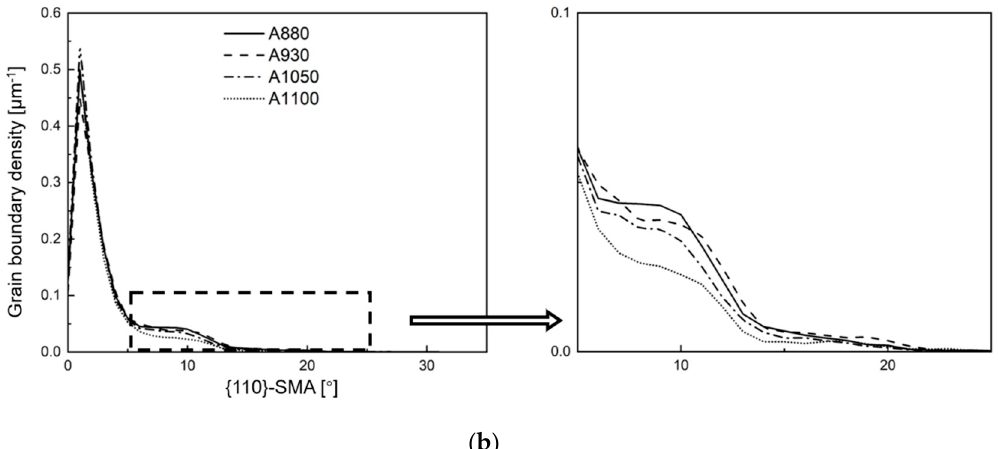
Figure 8. Boundary density distribution counted with: ( a ) {100}-SMA; and ( b ) {110}-SMA.